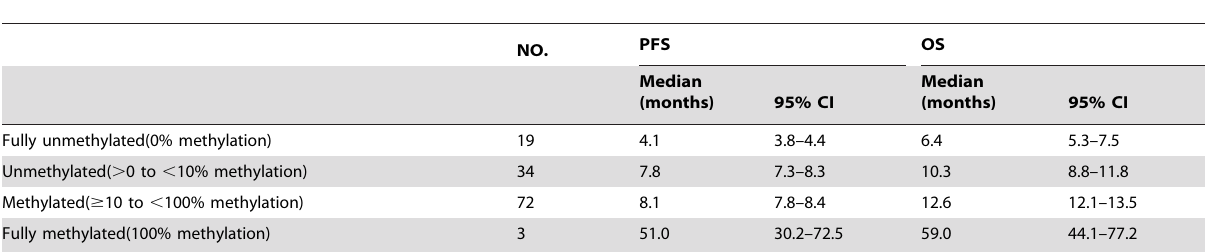
Table 3. Extent of MGMT promoter methylation and clinical outcome in Chinese glioblastoma patients*.